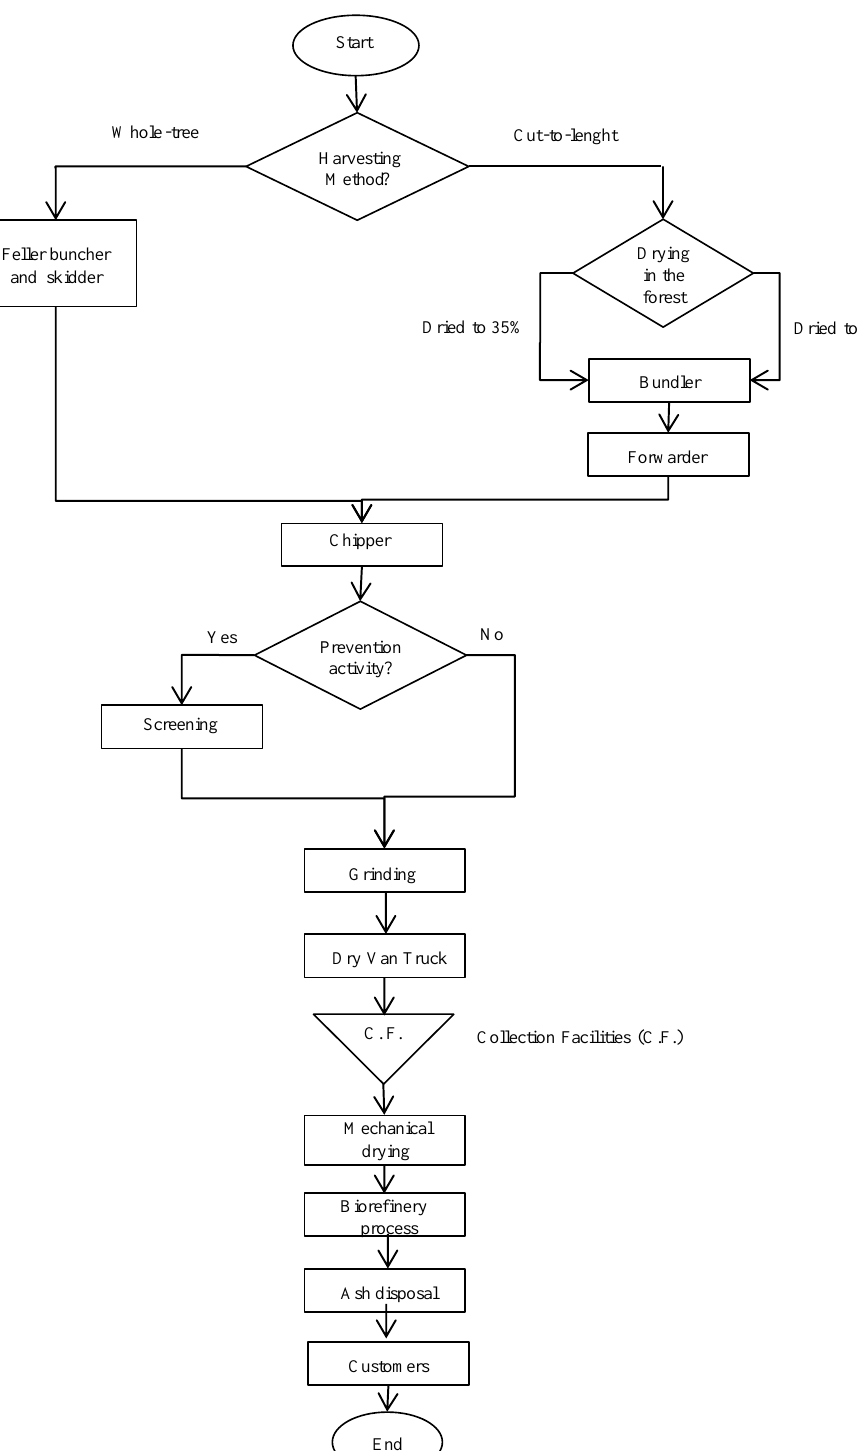
Figure 3. Logging residue collection options.